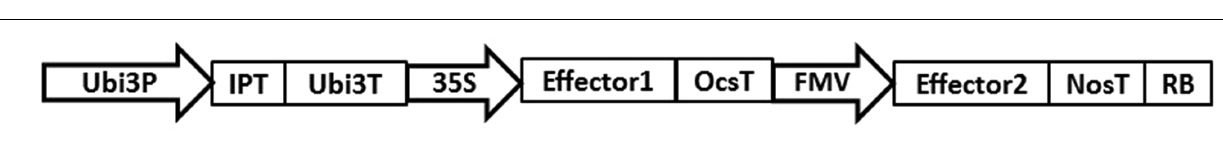
FIGURE 2 | Schematic of binary vector pSIM2170 that contains forward and reverse TALENs. Two TALENs were driven by either 35s or FMV constitutive promoter followed by either OCS or Nos terminator, respectively. Each TALEN has a SV40 nuclear localization sequence (NLS), designed repeat variable diresidue (RVD) (E3 or E4 repeat), and truncated C-terminal fused to a FokI cleavage domain. A potato Ubi3 promoter-driven ipt gene cassette was put on the left side of T-DNA and the T-DNA LB was removed in this